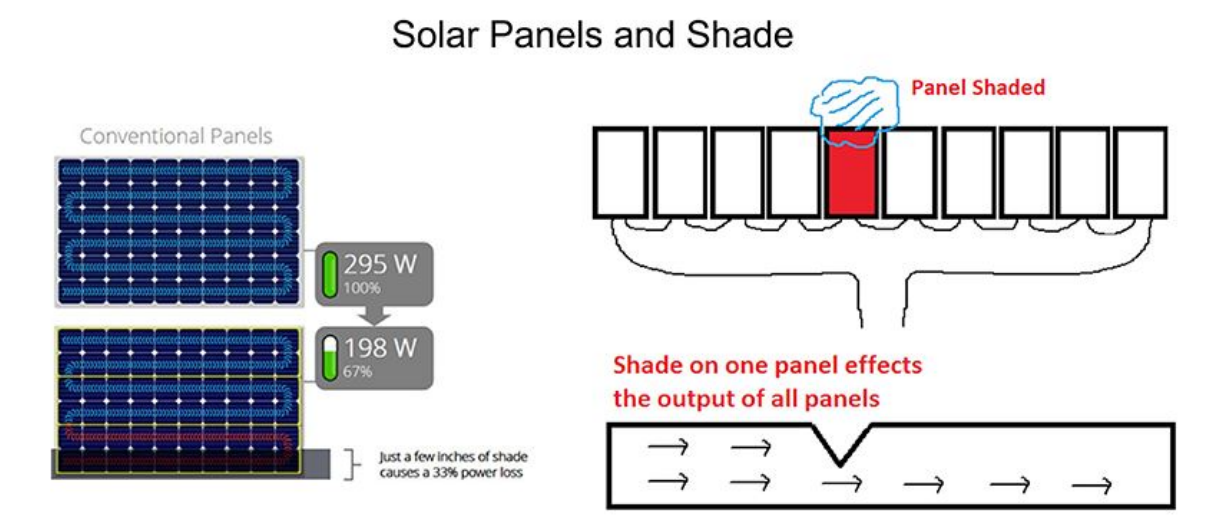
Figure 5. Shading effect on the performance of the solar panels